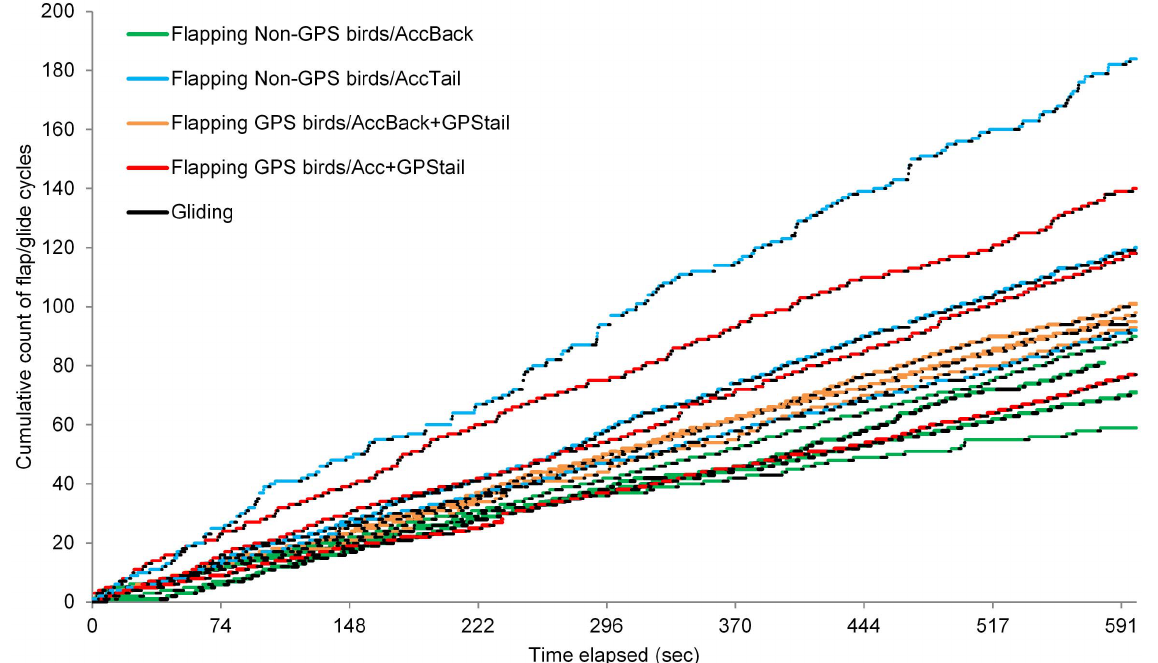
Figure 4. Details on the cyclic pattern during the flight of gannets. Cumulative count of flap/glide cycles over time measured for 14 gannets during a 10 minute flight after their departure from the breeding colony. The birds were equipped with miniature tri-axial accelerometers on their back or tail without (AccBack and AccTail respectively) or with, a dummy-GPS on their tail (AccBack-GPStail and Acc + GPStail respectively). The duration of the flapping period (in green, blue, orange or red depending on the bird group) is also shown relative to the duration of the gliding period (in black for all groups of birds).